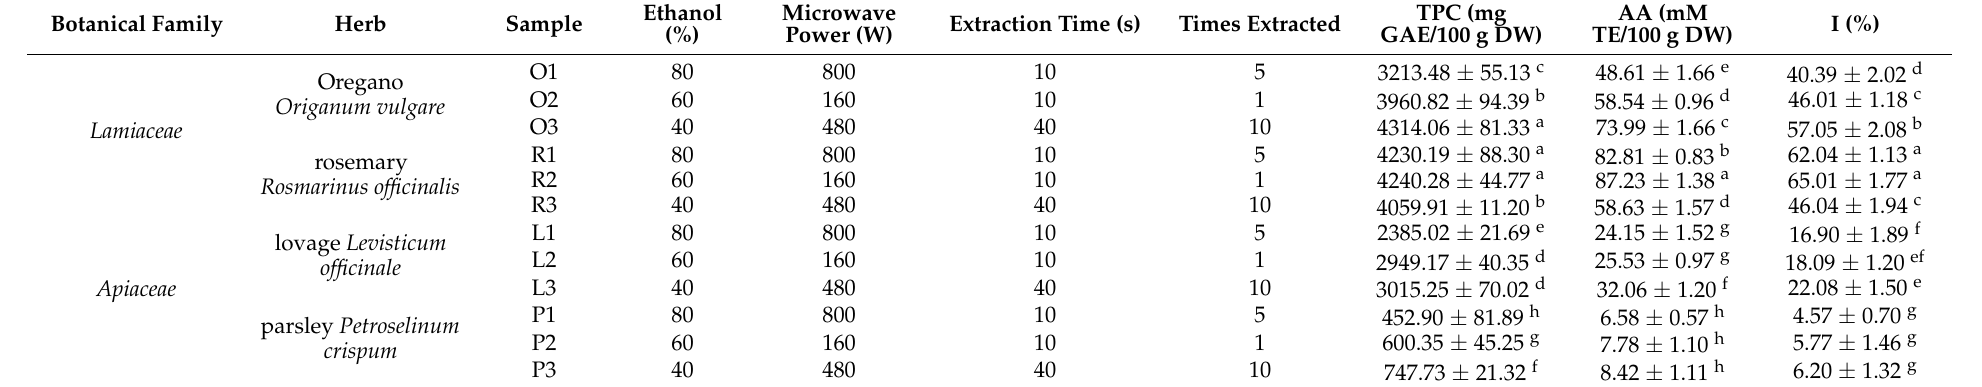
Table 2. Total polyphenol content and antioxidant activity of parsley, lovage, rosemary, and oregano by microwave-assisted